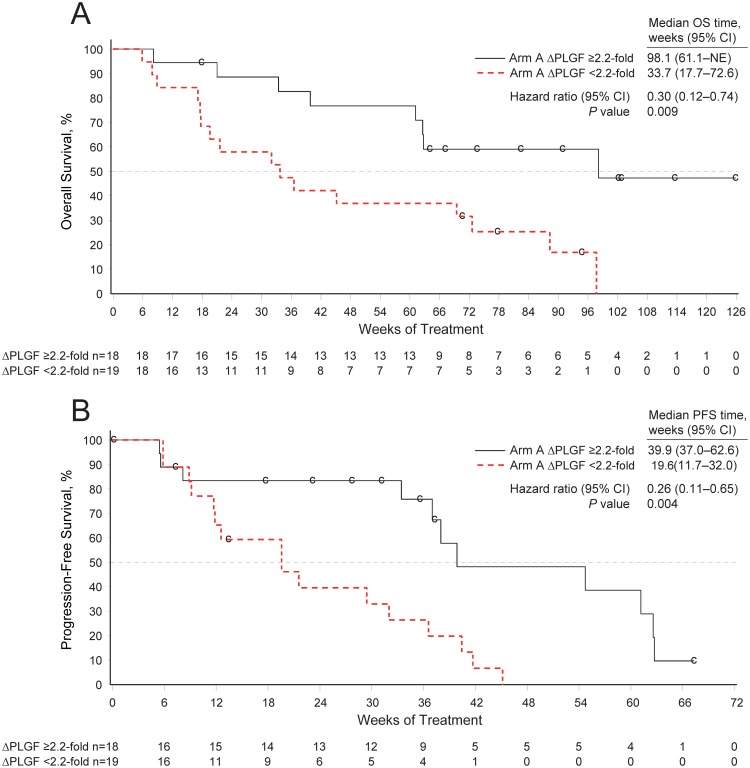
Association of fold-change in placental growth factor (PLGF) and outcomes in the phase 2 study.Overall survival (OS) (A) and progression-free survival (PFS) (B) in treatment Arm A among patients with a ≥2.2-fold (black line) or <2.2-fold (red line) fold-change from baseline in PLGF after 3 weeks of treatment with motesanib 125 mg QD. HR = hazard ratio; NE = not estimable; QD = once daily.